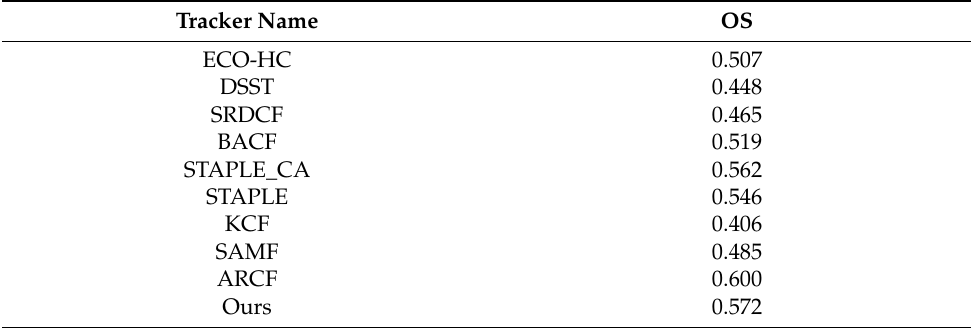
Table 3. The overall tracking results on the UAV123